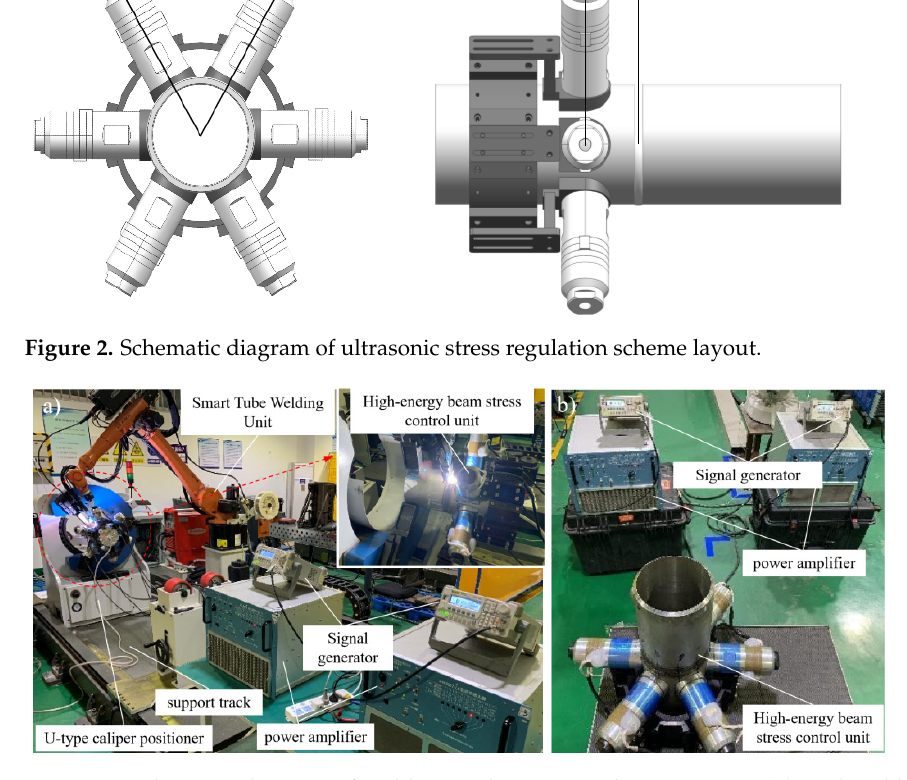
Figure 3. Schematic diagram of welding and stress regulation system: ( a ) Mid-welding online regulation; ( b ) Post-welding offline regulation.